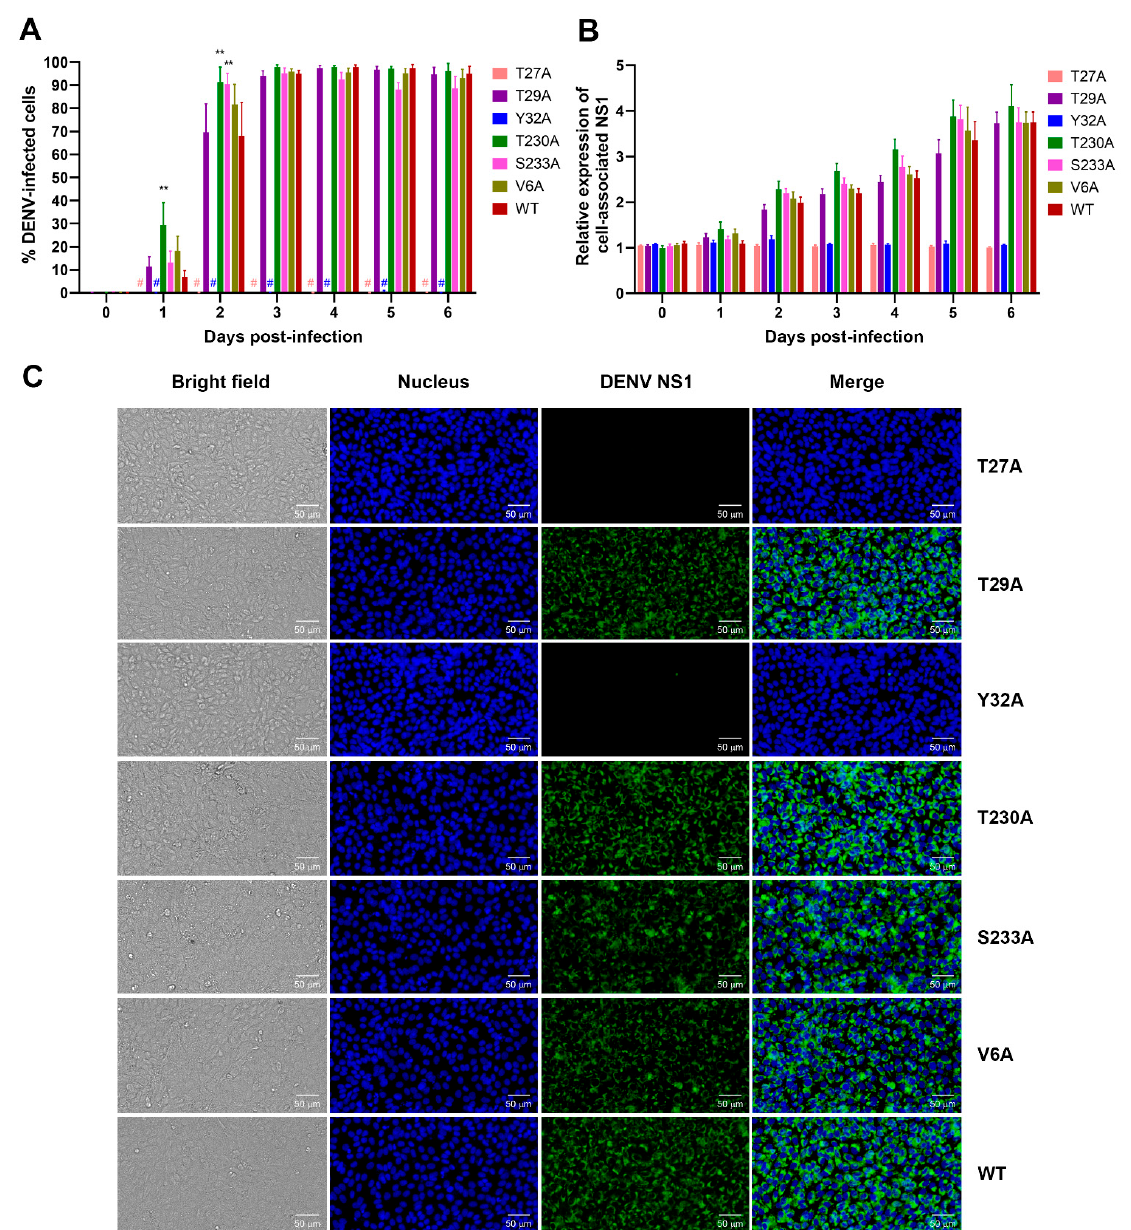
Figure 4. Effects of phosphorylation site mutations of DENV NS1 on DENV infection and NS1 expression. Vero cells were infected with wild-type DENV (WT) or different virus mutants (T27A, T29A, Y32A, T230A, S233A, or V6A). At varying time points post-infection, the infected cells were harvested and assessed for percentage of DENV-infected cells ( A ), for relative expression of cell-associated NS1 ( B ), and for the pattern of DENV NS1 expression ( C ) by immunofluorescence staining with a specific anti-NS1 antibody and high-content imaging and analysis. The results in ( A ) and ( B ) show the mean ± SEM of four independent experiments (** p < 0.05; #no detectable DENV-infected cells). Representative images of NS1-expressing cells are shown in ( C ).